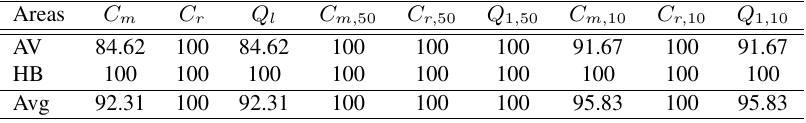
Table 1. Building detection results: object-based evaluation for the Aitkenvale ( AV ) and Hervey Bay ( HB ) data sets in percentage. C m = completeness, C r = correctness and Q l = quality, are for buildings of 50 m 2 and 10 m 2 Areas